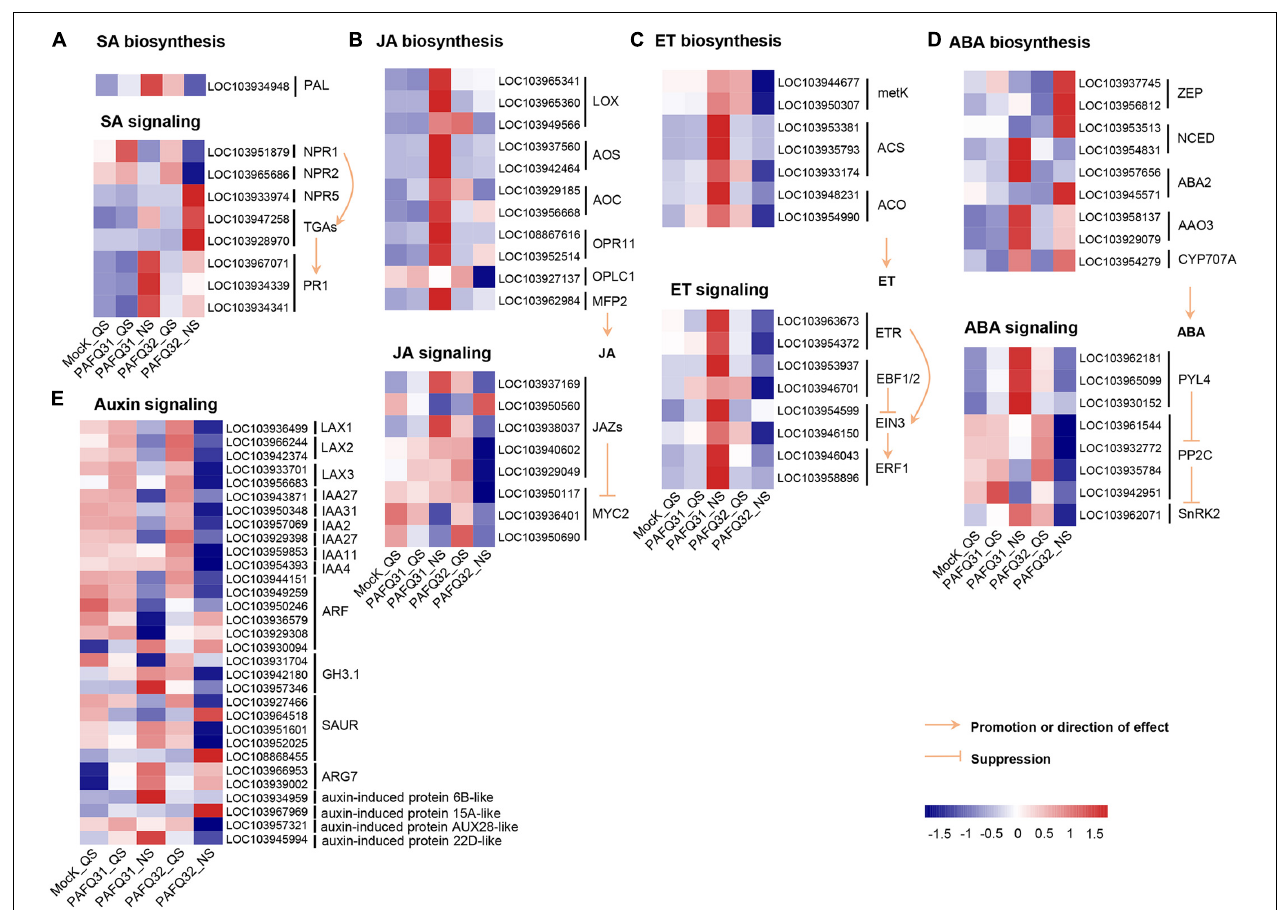
FIGURE 4 | Heatmap analyses of DEGs related to phytohormone signal transduction pathways in the leaves of P. pyrifolia in response to C. fructicola infection. (A–E) Heatmap of the DEGs involved in the salicylic acid (SA), jasmonic acid (JA), ethylene (ET), abscisic acid (ABA), and auxin pathway, respectively.